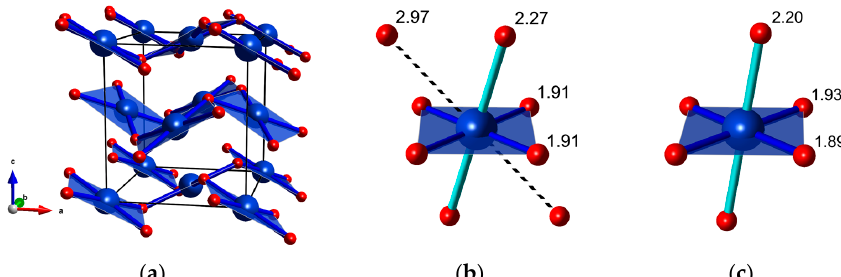
Figure 4. ( a ) The fluorite-type Pbca structure CuF 2 (for clarity only the four shortest Cu-F bonds are shown); ( b ) the coordination of Cu 2+ in Pbca calculated at 9 GPa; and ( c ) the coordination of Cu 2+ in P2 1 / c calculated at 9 GPa; Cu-F distances are given in Å.